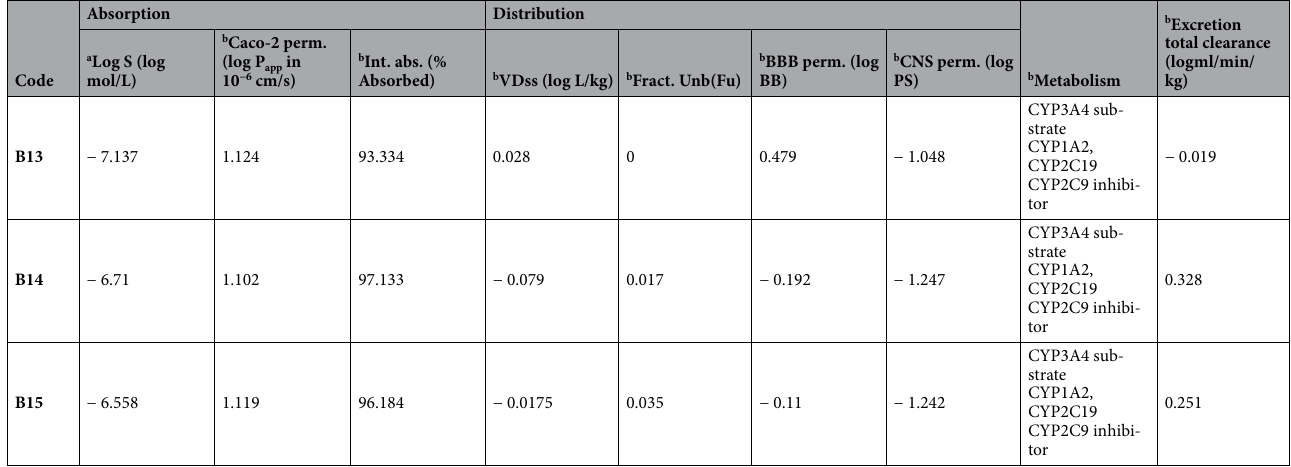
tion, therefore. Every molecule has some sort of interaction with cytochromes, whether it be as an inhibitor or a substrate. The study revealed that all benzyloxy chalcones had a reduced total clearance of − 0.196 to 0.755